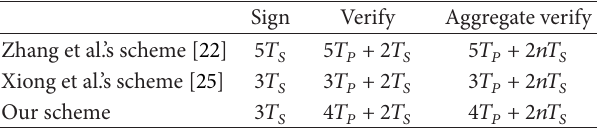
Table 1: Performance